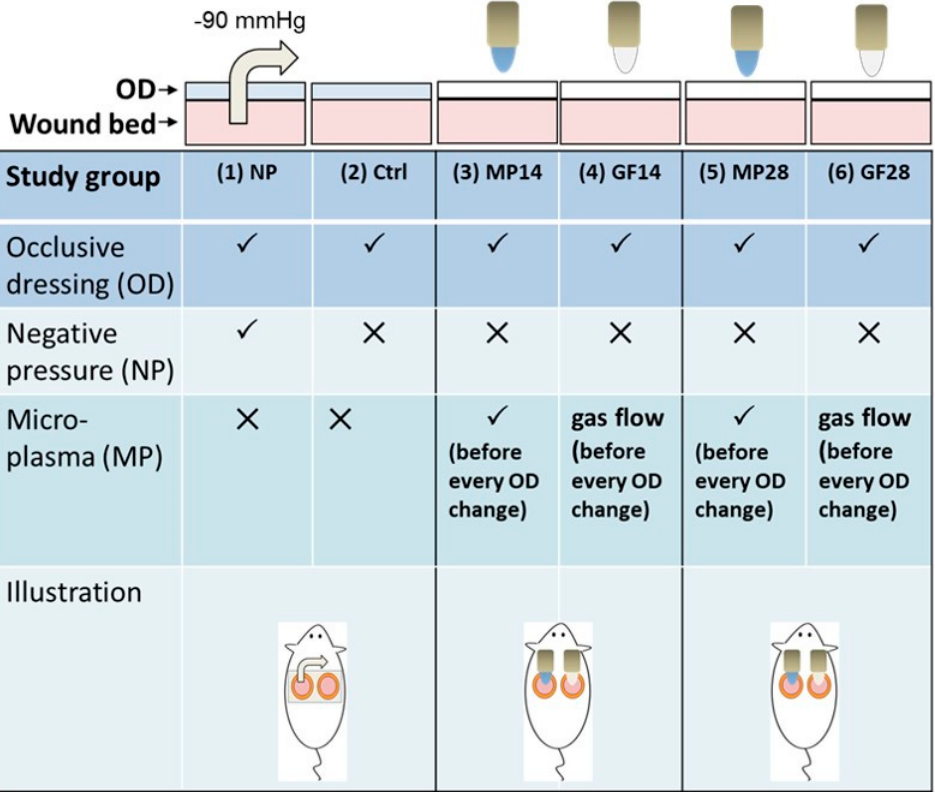
Figure 7. Schematic representation of the animal testing model with six study groups: (1) NP, (2) Control (Ctrl), (3) MP14, (4) GF14, (5) MP28, and (6) GF28. The operation sequences for MP treatment and negative NP therapy in mice are also illustrated.